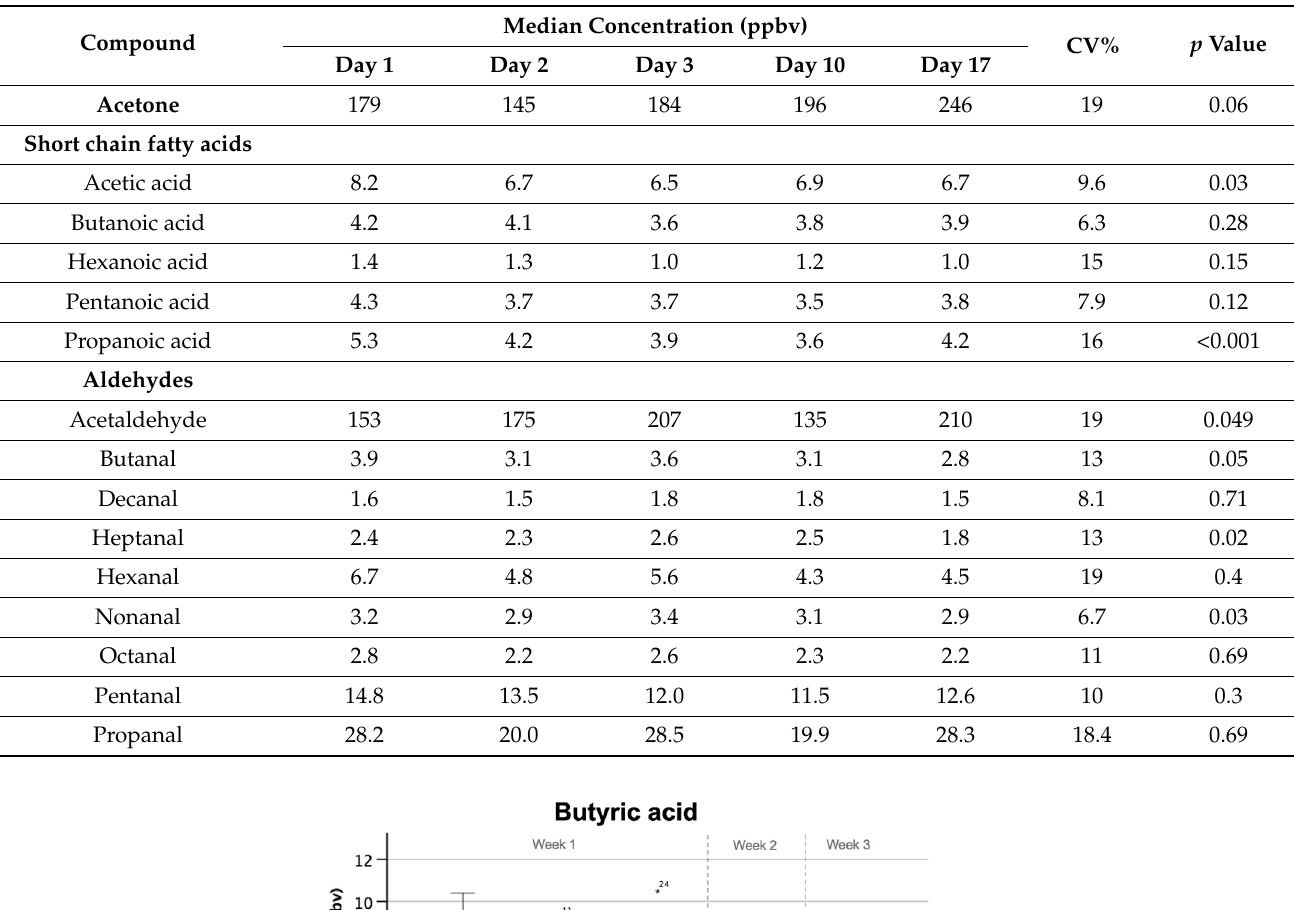
Table 2. Longitudinal variation of the concentrations (ppbv) of target short chain fatty acids and aldehydes in saliva.